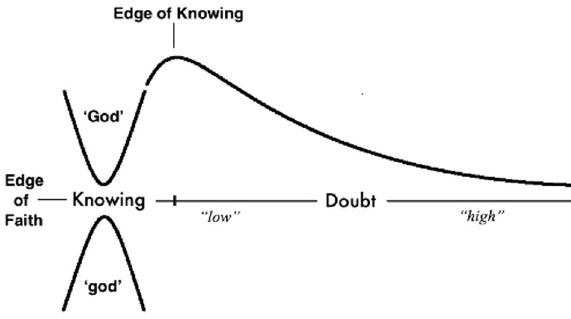
Fig. 3 Illustration of two mutually exclusive paradigms. The part above the horizon belongs to the paradigm of belief, below the horizon belongs to